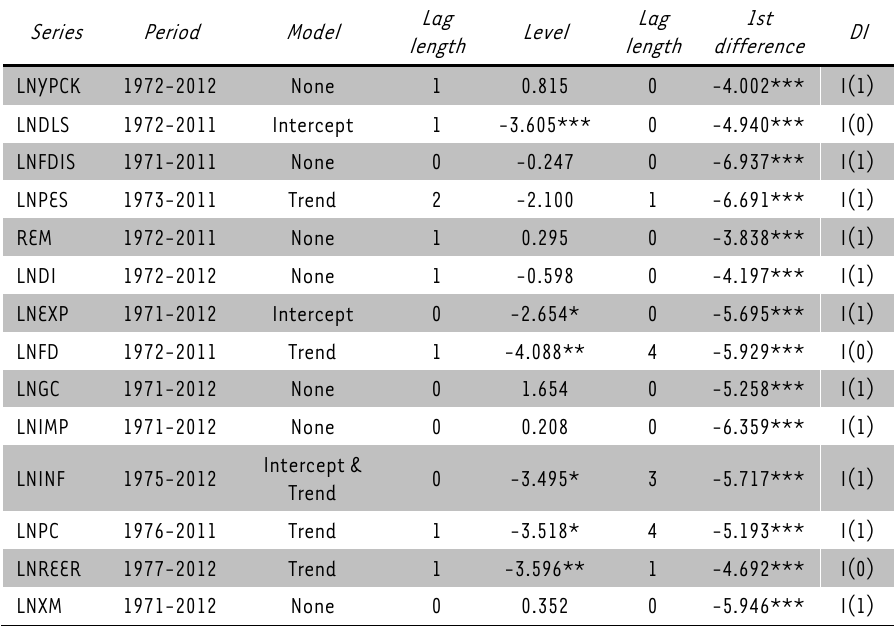
TABLE 3: ADF Unit root test